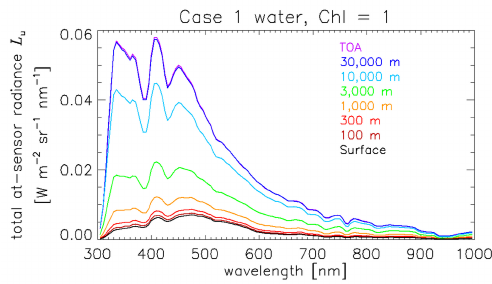
Figure 2. At-sensor radiances for a variety of altitudes. Increasing the altitude leads to an increase in the deterioration of the signal due to the atmospheric effects, which demonstrates the importance of accounting for the vertical distribution of aerosols (especially absorbing aerosols). The data were created with a radiative transfer simulation where the contributions of the surface effects and water-leaving radiance remained constant for all of the sensor altitudes [152]. Figure courtesy of C. Mobley, Ocean Optics Web Book [152].